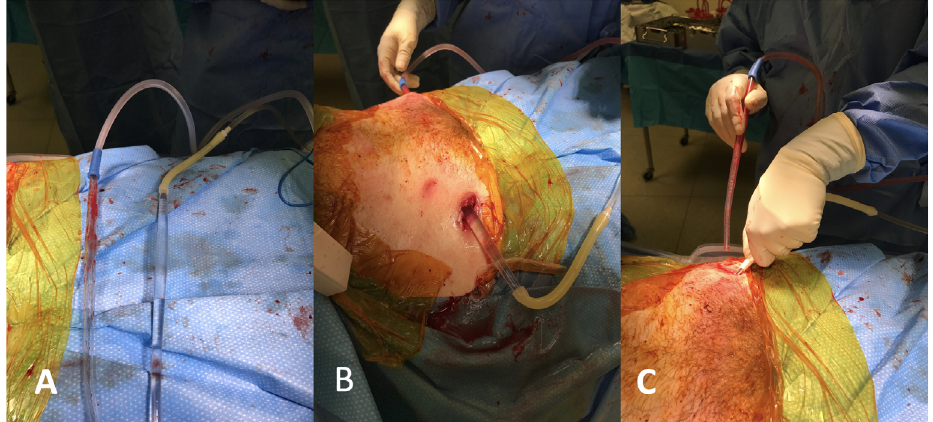
Figure 1. (a) After removing the implants, the wounds were washed with 6 – 9 L of Normal Saline with cystoscopy tubing and a plastic Yankour tip. (b) For the subcutaneous tunnel of the bar, on one side, the saline fl owed in, and on the other, we used suction. (c) The pin sites were also curetted in the bone and washed with smaller tips fastened to the cystoscopy